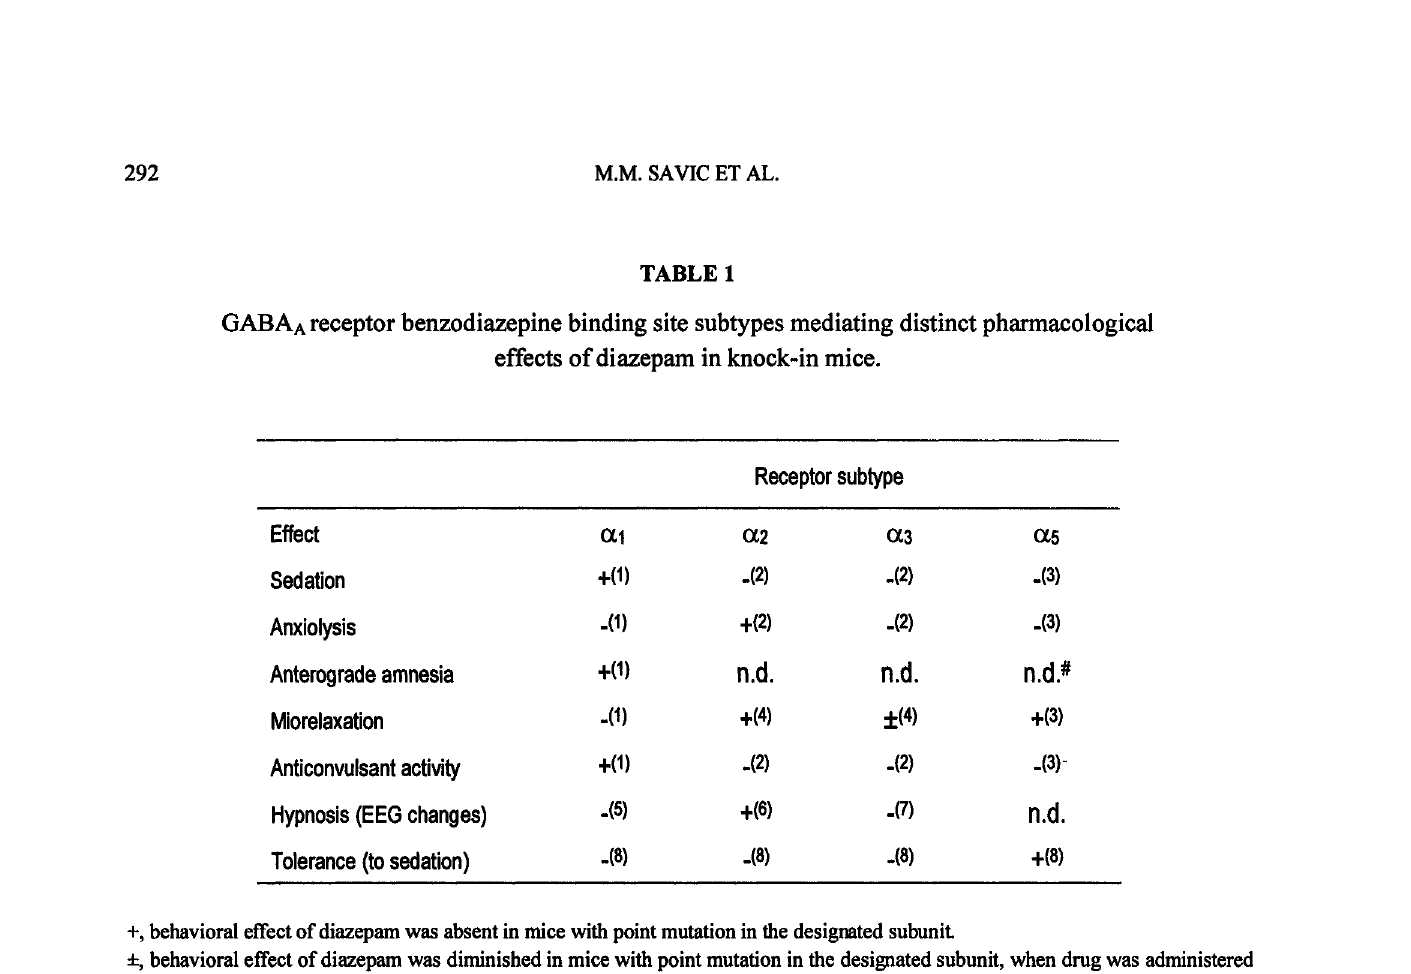
GABAA receptor benzodiazepine binding site subtypes mediating distinct pharmacological effects of diazepam in knock-in